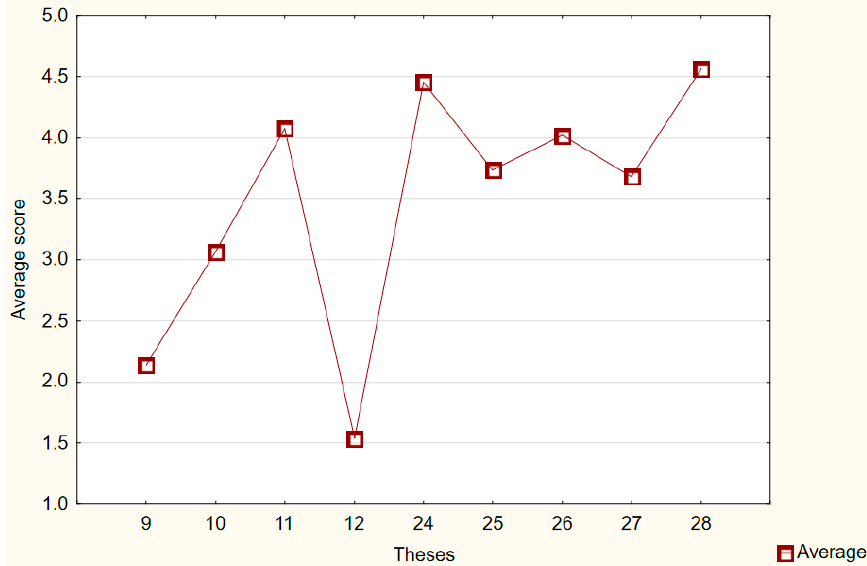
Figure 4. Average ratings relating to the quality of the environment and the benefits of energy production from renewable sources. production from renewable